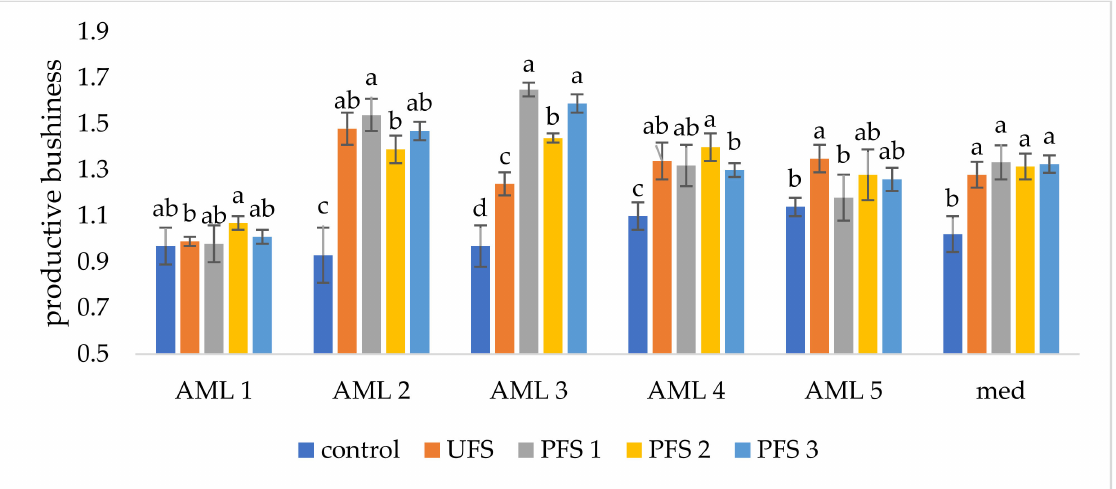
Figure 4. Productive bushiness of winter wheat plants in the